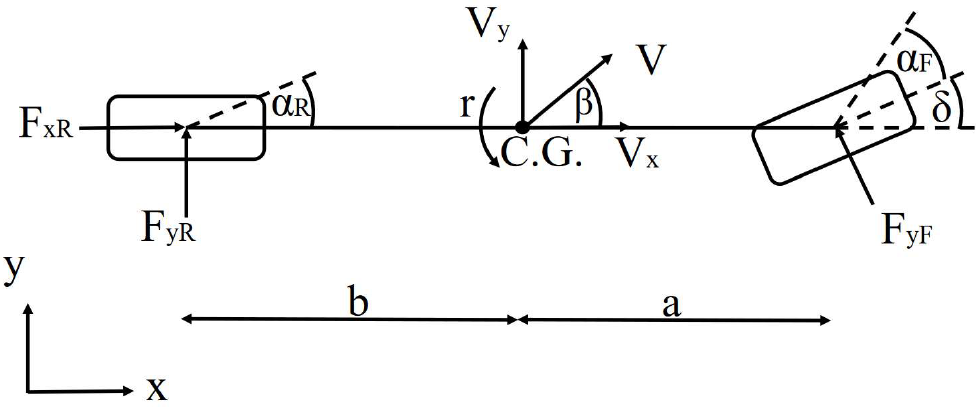
Figure 1. Bicycle model notations used in the equations.